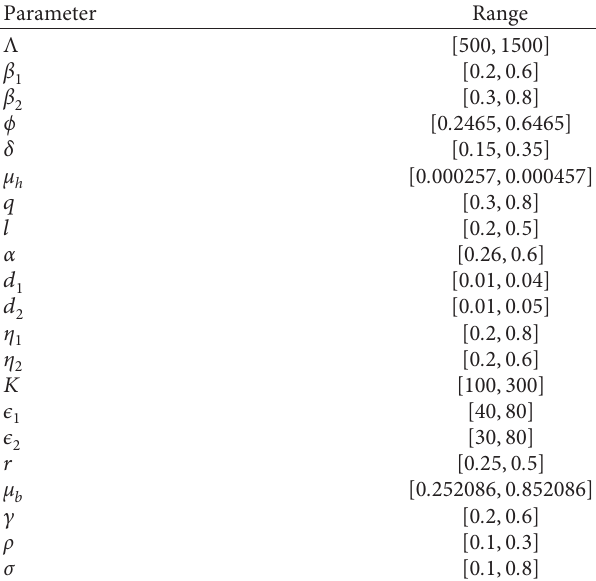
Table 4: Parameter value ranges of model (1) used as input for the LHS